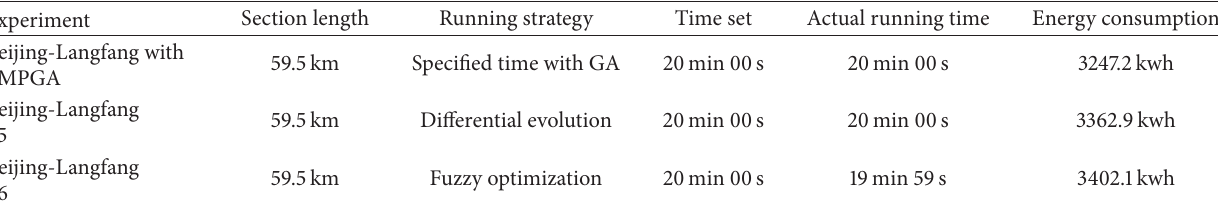
Table 5: Experiment confrontation with other